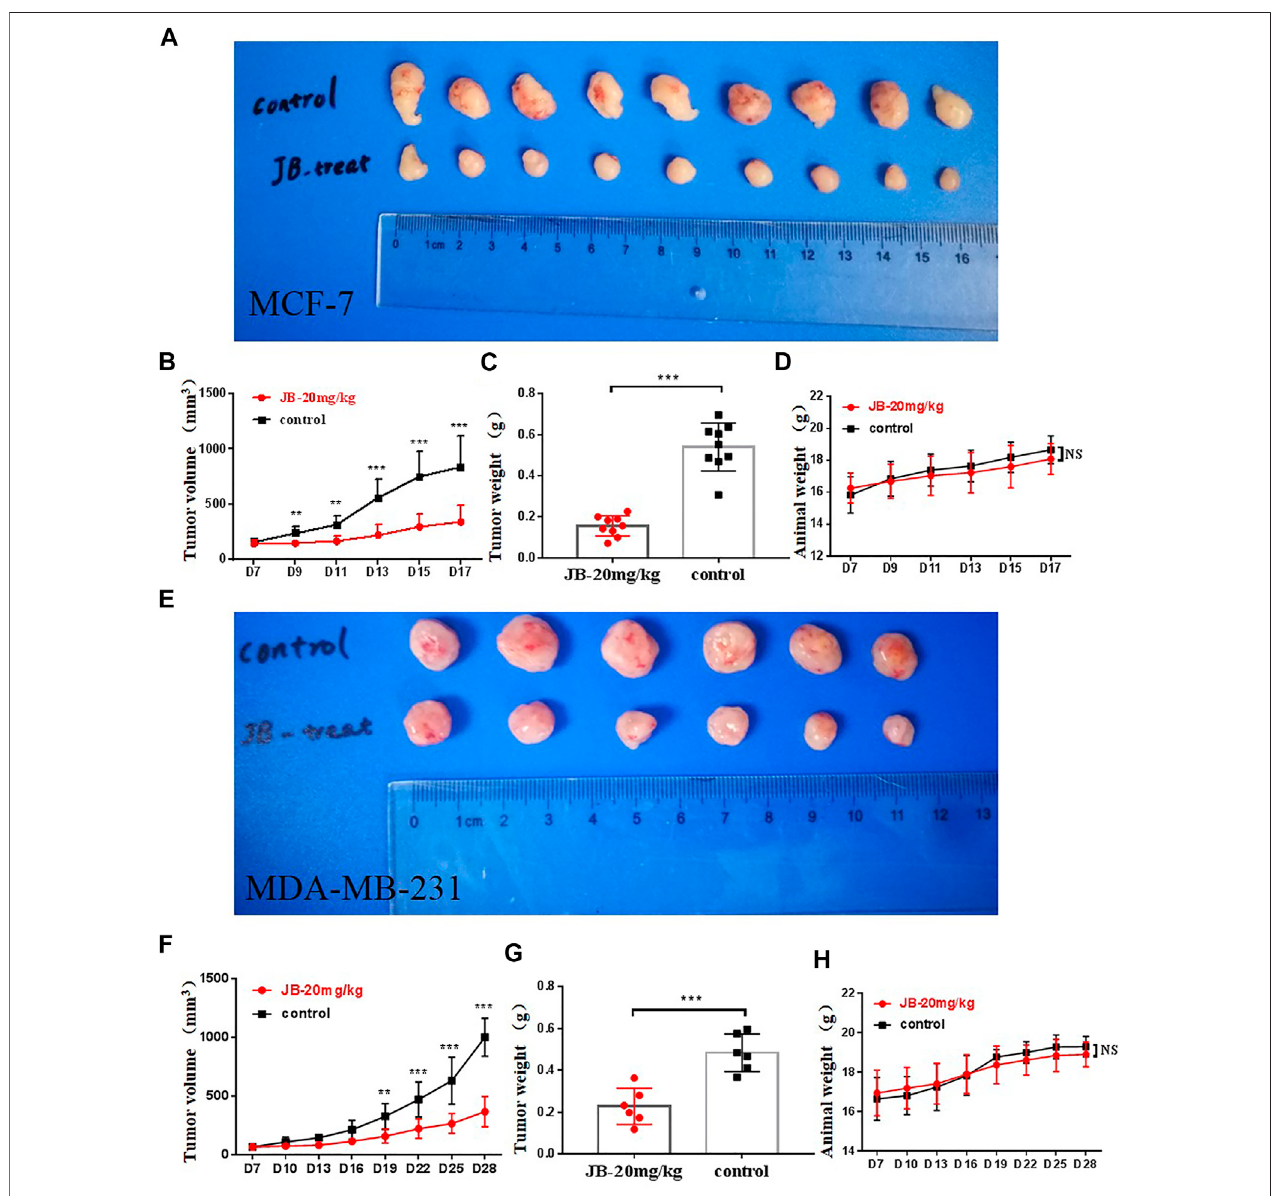
FIGURE 6 | JBsuppressestumorgrowth invivo .JBsigni fi cantlyinhibitedthetumorgrowthofMCF-7 (A,B) andMDA-MB-231 (E,F) .ThetumorweightsoftheJB-treated group were much lower than those of the control group (C,G) . There is no signi fi cant difference between animal weights of the JB- or vehicle-treated group (D,H) . The values of tumor volume and weight were analyzed and presented by mean ± SEM, n (cid:2) 9 or 6. * p < 0.05 vs. control group; ** p < 0.01 vs. control group; *** p < 0.001 vs. control group.